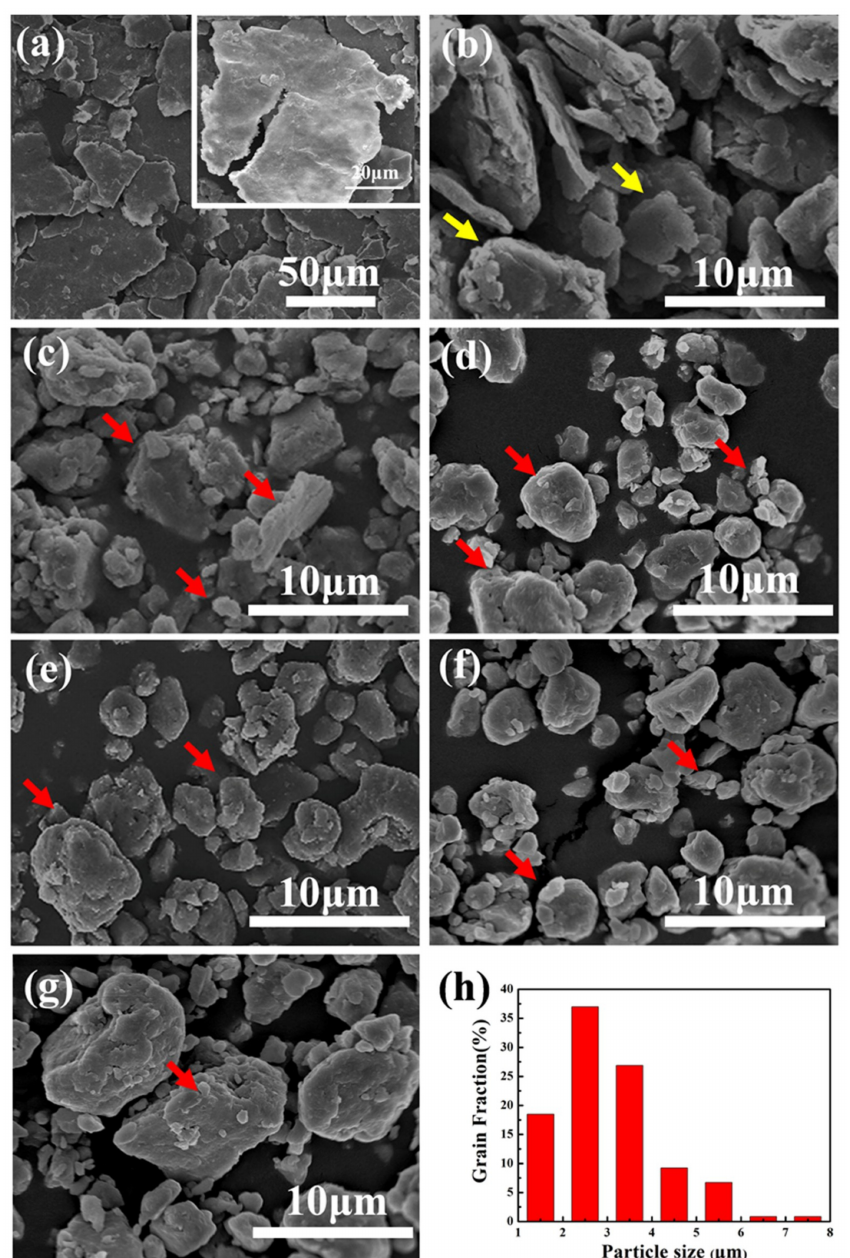
Figure 3. Morphologies of Al-7Zn-2.5Cu-2.5Mg milled powders with di ff erent ball milling time ( a ) P5, ( b ) P10, ( c ) P15, ( d ) P20, ( e ) P25, ( f ) P30, ( g ) P40 and ( h ) histogram of P30 particles size